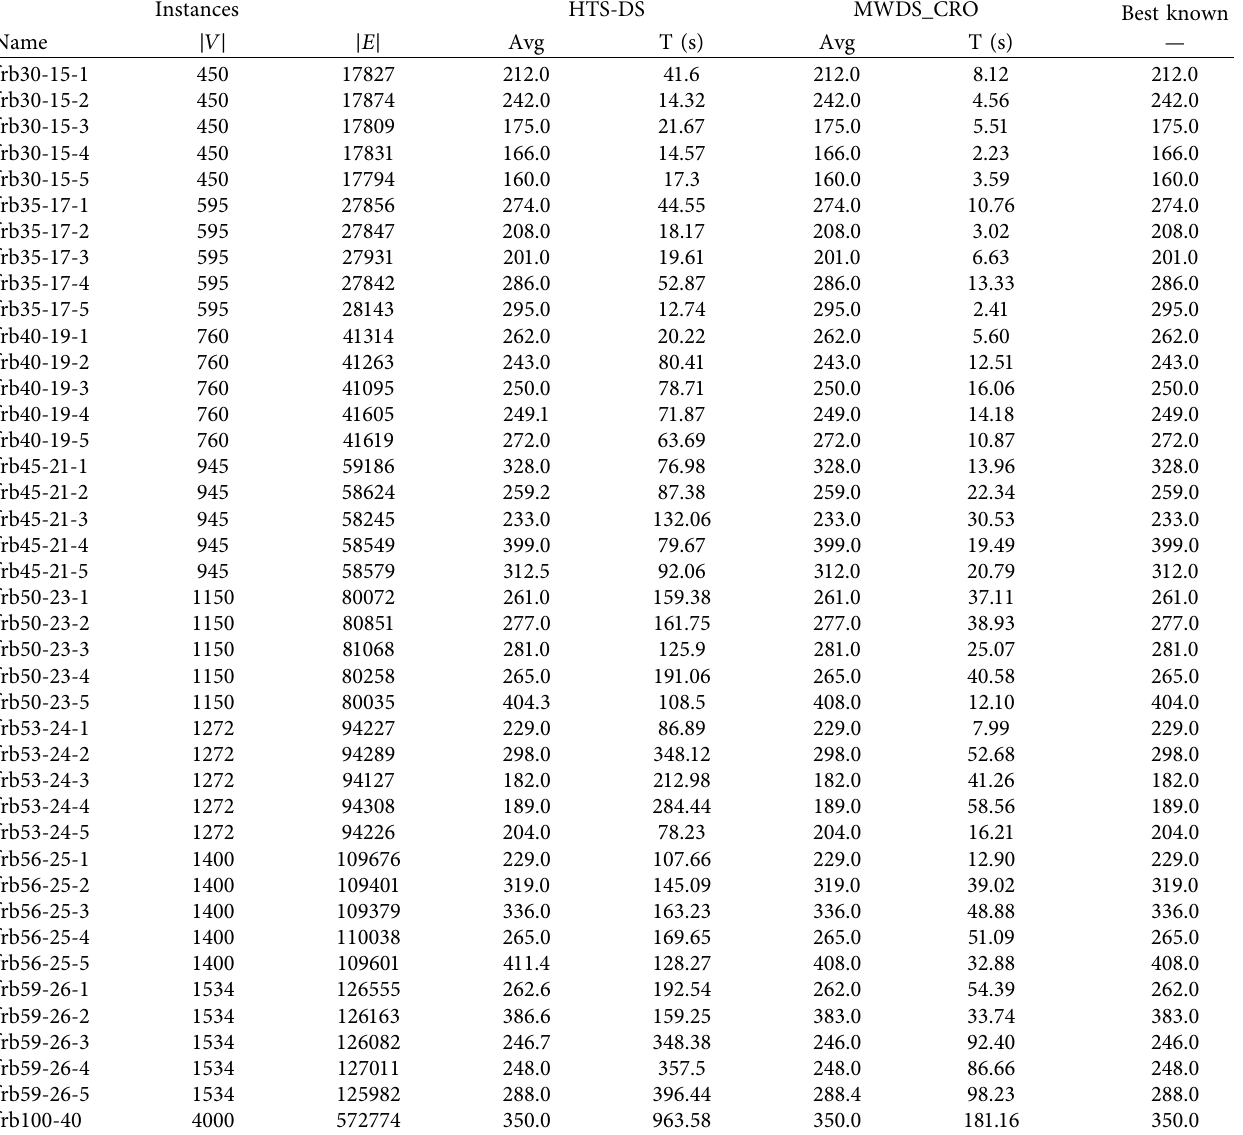
Table 7: BHOSLIB-comparison of MWDS_CRO for various parameters with the recent state-of-the-art algorithm.